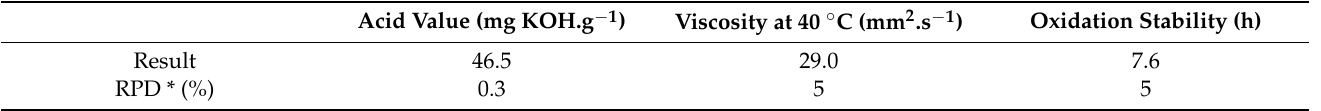
Table 2. Physicochemical properties of rice bran